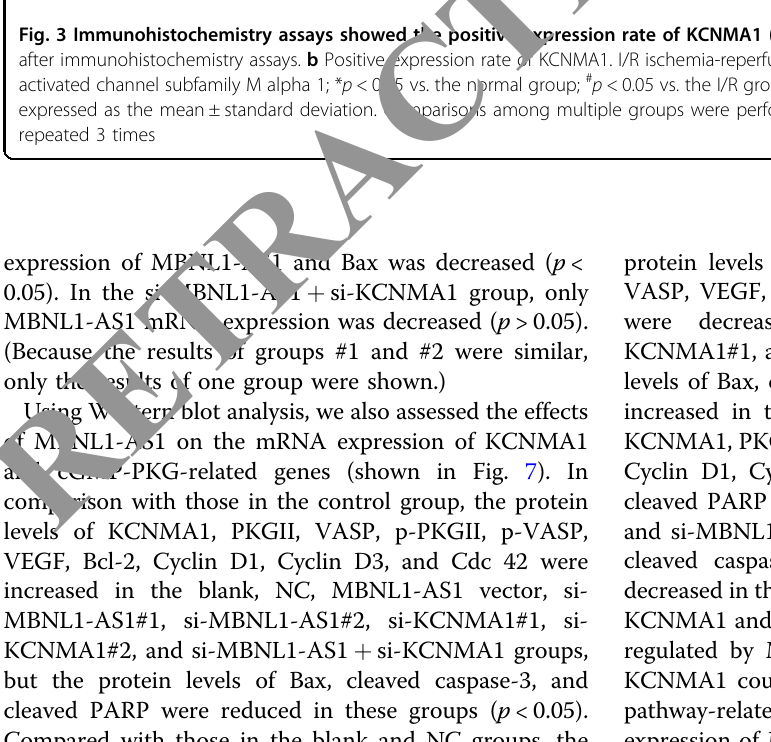
expression of MBNL1-AS1 and Bax was decreased ( p < 0.05). In the si-MBNL1-AS1 + si-KCNMA1 group, only